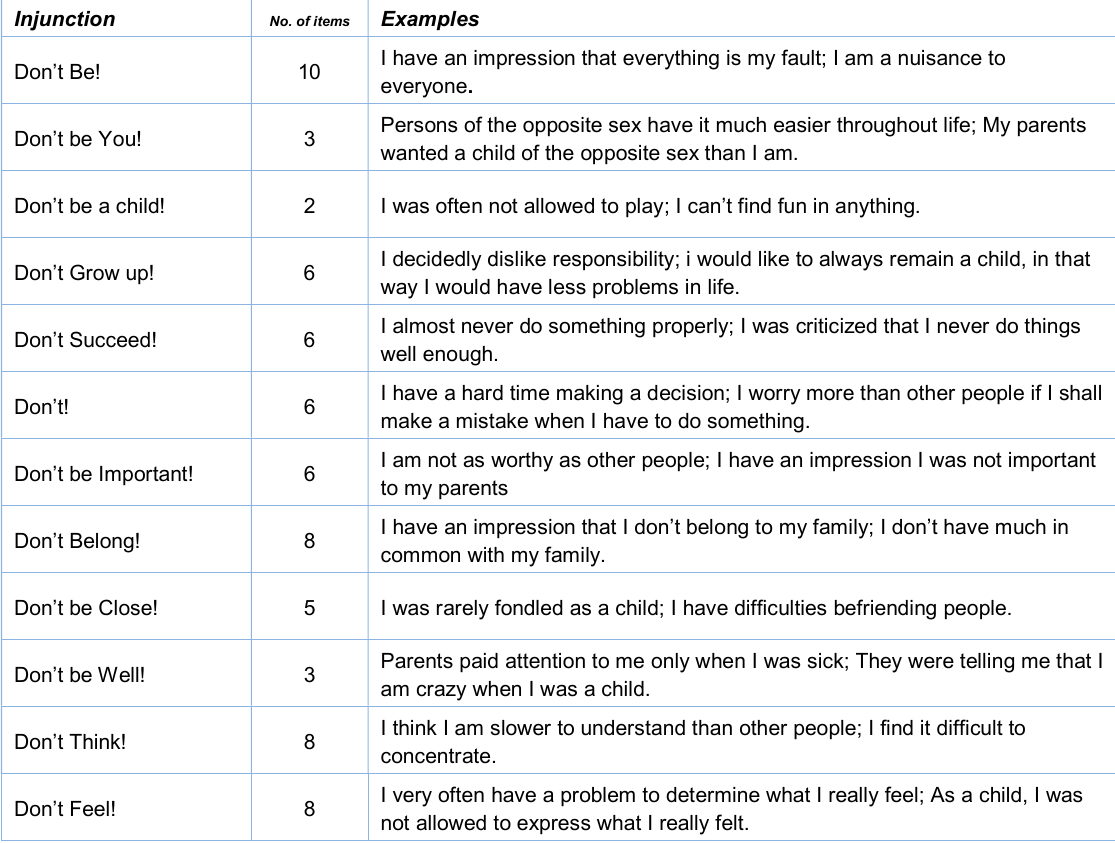
Table 1: Examples of items (translated) comprisng 12 subscales Injunction No. of